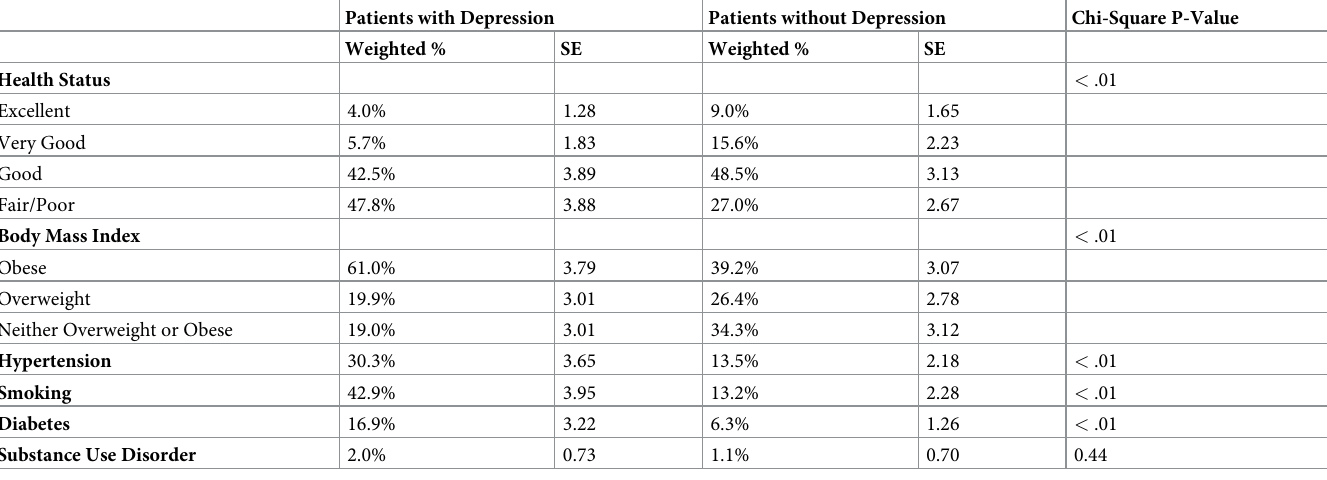
Table 4. Physical health status and conditions of female patients with depression and of reproductive age (15–49 yrs) served at HRSA funded health centers. Patients with Depression Patients without Depression Chi-Square P-Value Weighted % SE Weighted